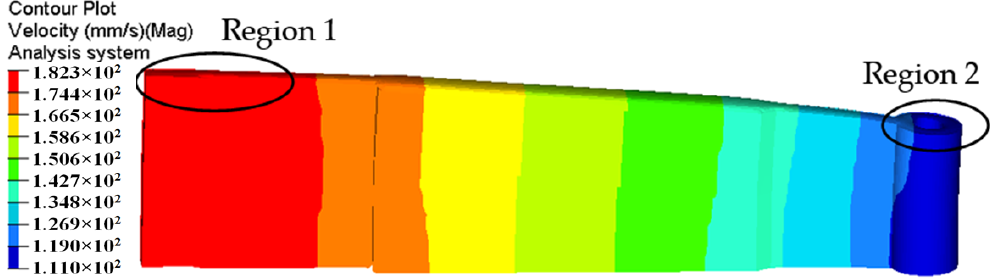
Figure 5. Velocity distribution in the extruded profile for the traditional die design.